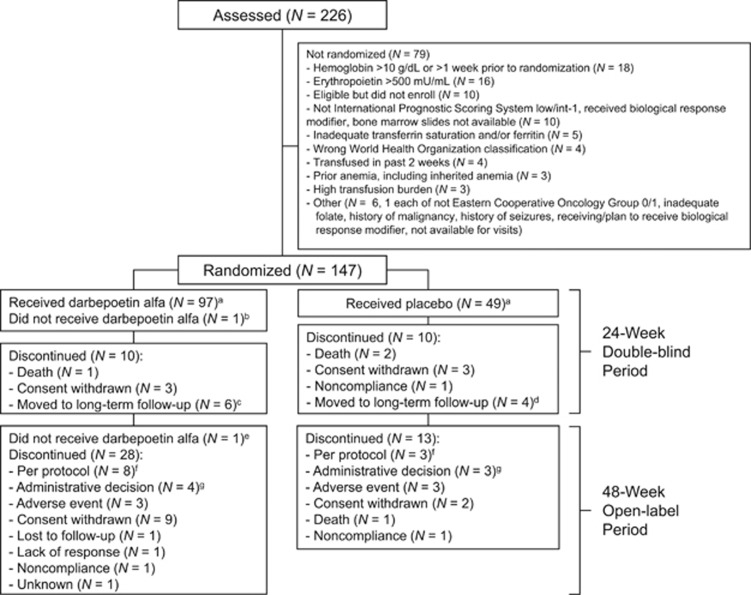
Patient disposition. aPrimary analysis sets. bSerum EPO⩽500 mU/ml locally but >500 mU/ml centrally, so patient was withdrawn. cFor adverse event (n=2), protocol (n=2), administrative (n=1) and other (n=1). dFor adverse event (n=2), consent withdrawn (n=1) and protocol (n=1). eColon adenocarcinoma (T1aN0M0) treated with polypectomy. fPer dosing algorithm (n=9), progression to AML (n=2, both prior darbepoetin alfa). gPer investigator (n=2), lack of response (n=2) and unknown (n=3).